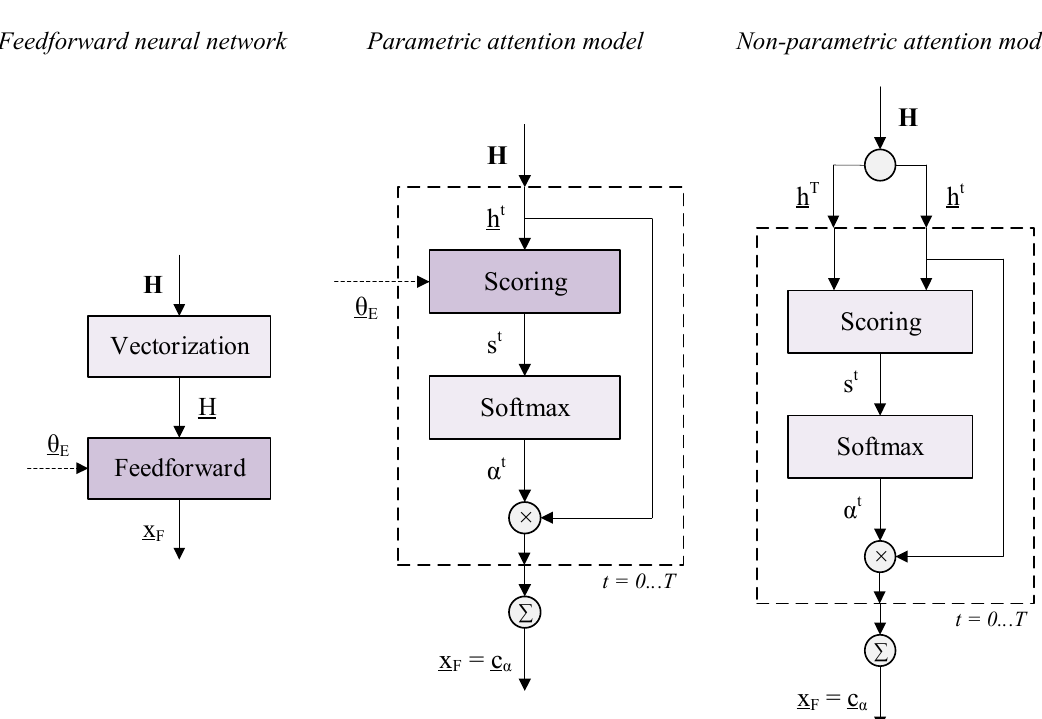
Figure 8. Embedding functions using feedforward neural network ( left ), parametric attention model ( middle ) and non-parametric attention model ( right ) .